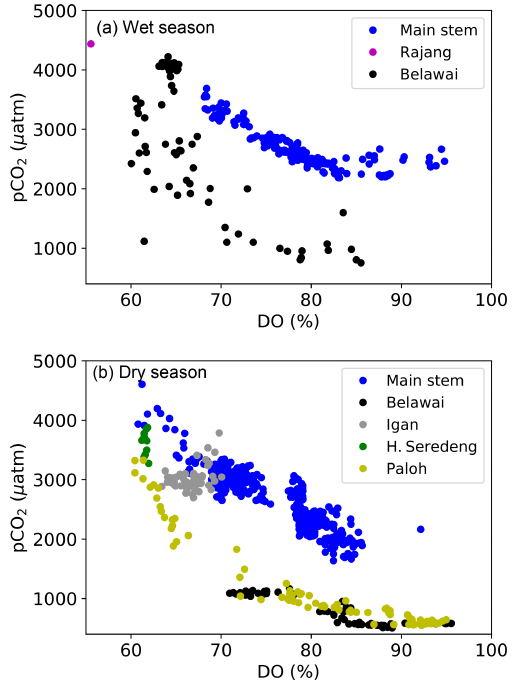
Figure 5. Correlation of p CO 2 vs. dissolved oxygen (DO) in the wet and dry season for individual